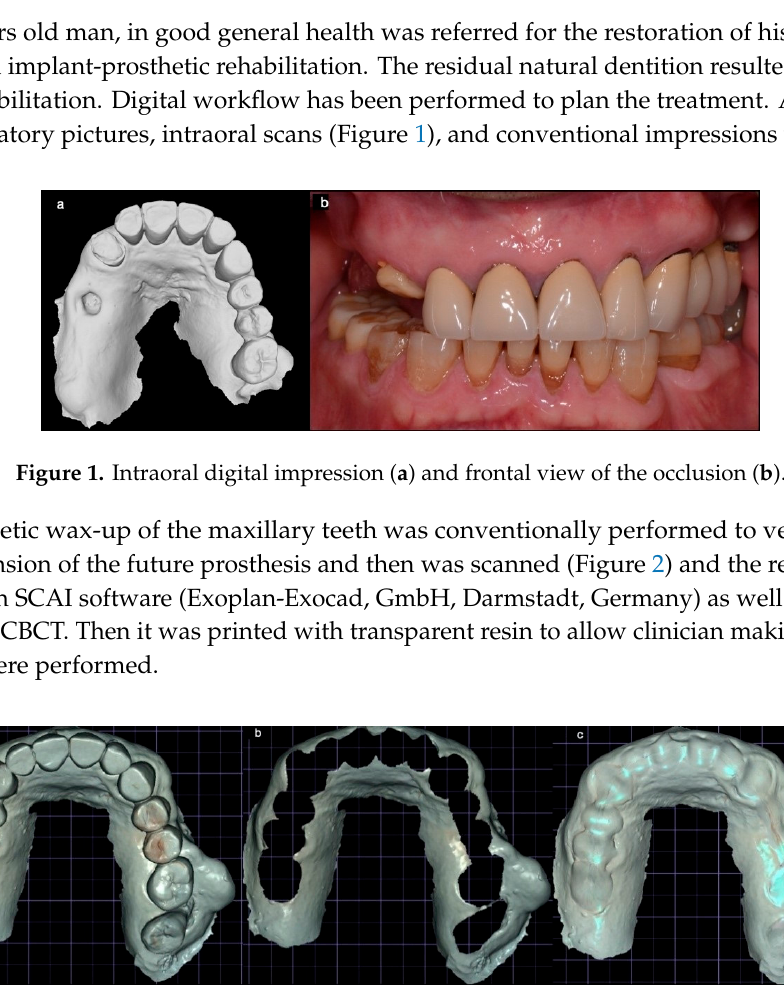
Figure 2. The virtual model obtained after the scanning of the waxed-up plaster cast ( a ). The virtual model after the digital cancellation of the teeth ( b ). The virtual model after the digital filling of the empty spaces ( c ).